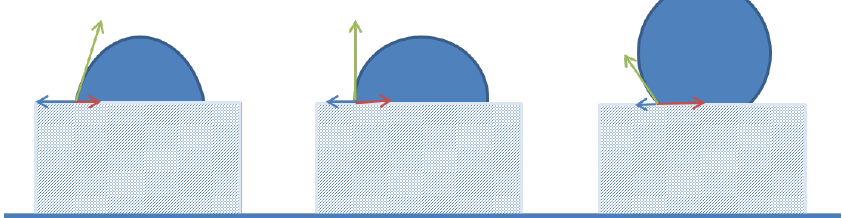
Figure 6. Schematic illustration of the effect of wettability changes that occur in the continuous phase only, going from a weak interaction between continuous phase and solid material (high contact angle for the continuous phase, and high surface free energy that is illustrated in the length of the blue arrow) to increasingly more favorable interactions, which lead to lower contact angles, and ultimately in a change in polarity on the left, with a contact angle < 90° for the continuous phase.